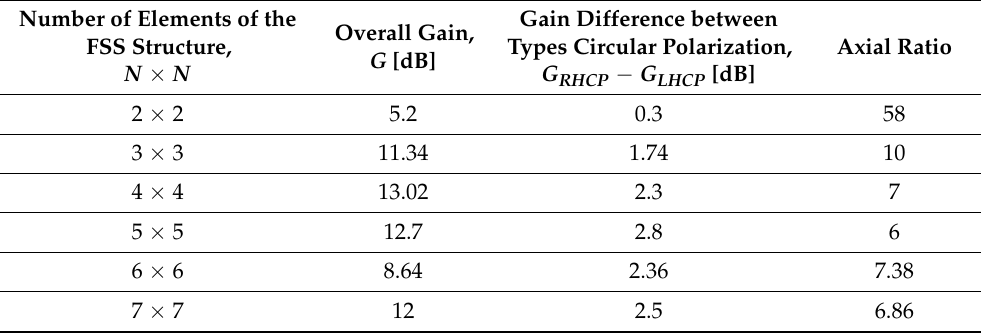
Table 2. Finding the position of the FSS layers with respect to the horn aperture.